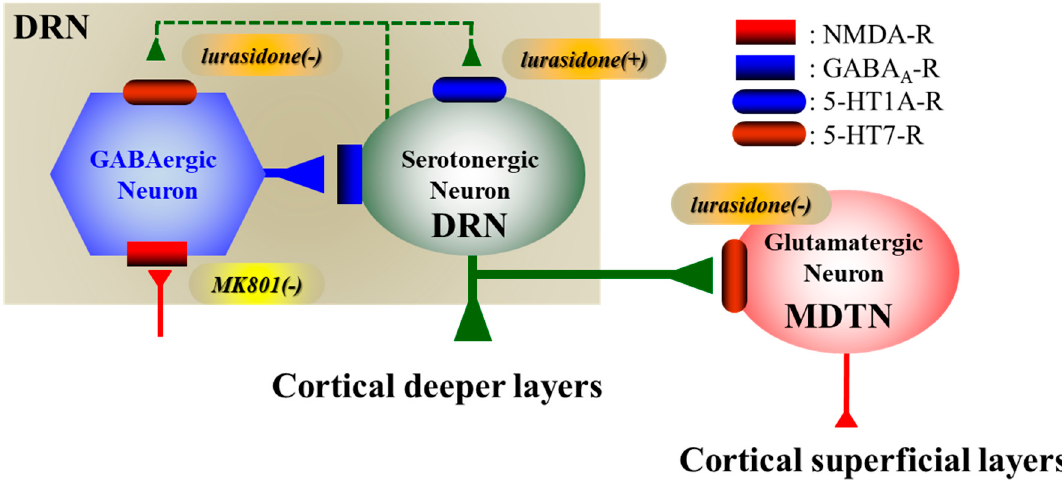
Figure 8. Proposed hypothesis for the extended neural circuitry involved in the DRN, MDTN and mPFC. Our proposed hypothesis for the extended neural circuitry involved in the transmissions of DRN-MDTN and the DRN-mPFC pathways. Serotonergic neurons in the DRN (green circle), which receives intra-DRN GABAergic inhibition, project terminals to the MDTN and deeper layers in the mPFC. GABAergic neurons in the DRN are predominantly regulated by excitatory 5-HT7R and NMDA-R rather than inhibitory 5-HT1AR. In contrast, serotonergic neurons in the DRN are regulated by inhibitory 5-HT1AR rather than excitatory 5-HT7R and NMDA-R. MK801 inhibits NMDA-R on the GABAergic neurons resulting in increase in 5-HT releases in the DRN, MDTN and mPFC; however, lurasidone acutely also enhances GABAergic disinhibition via its 5-HT7R antagonism but inhibits serotonergic neuronal activity via its 5-HT1AR agonism in the DRN. Contrary to acute treatment, lurasidone chronically, enhances 5-HT release via desensitization of 5-HT1AR and 5-HT7R in the DRN.